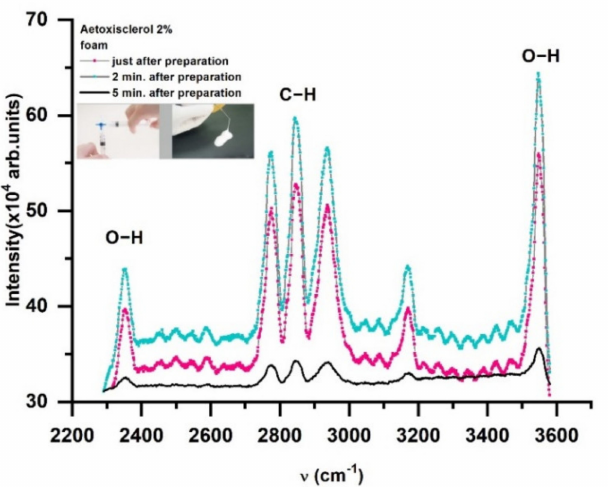
Figure 4. The influence of foam stability on the Raman spectra of Aetoxisclerol sclerosant